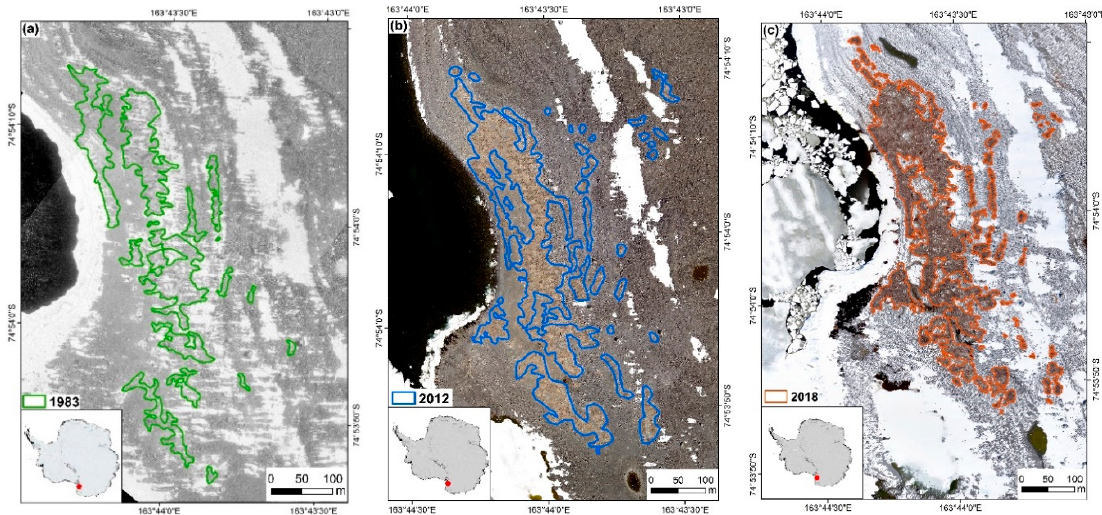
Figure 4. Spatial distributions of penguin colonies on Inexpressible Island in the Ross Sea, Antarctica during 1983–2018. Green, blue and red polygons show colony boundaries in 1983 ( a ), 2012 ( b ), and 2018 ( c ), respectively.